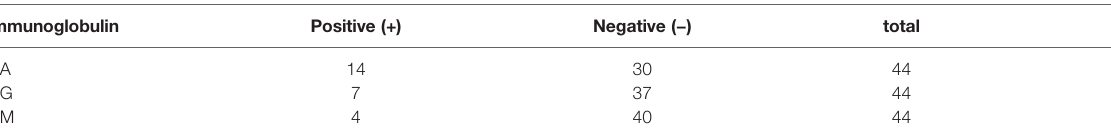
TABLE 2 | Positive rate of immunoglobulins in saliva.